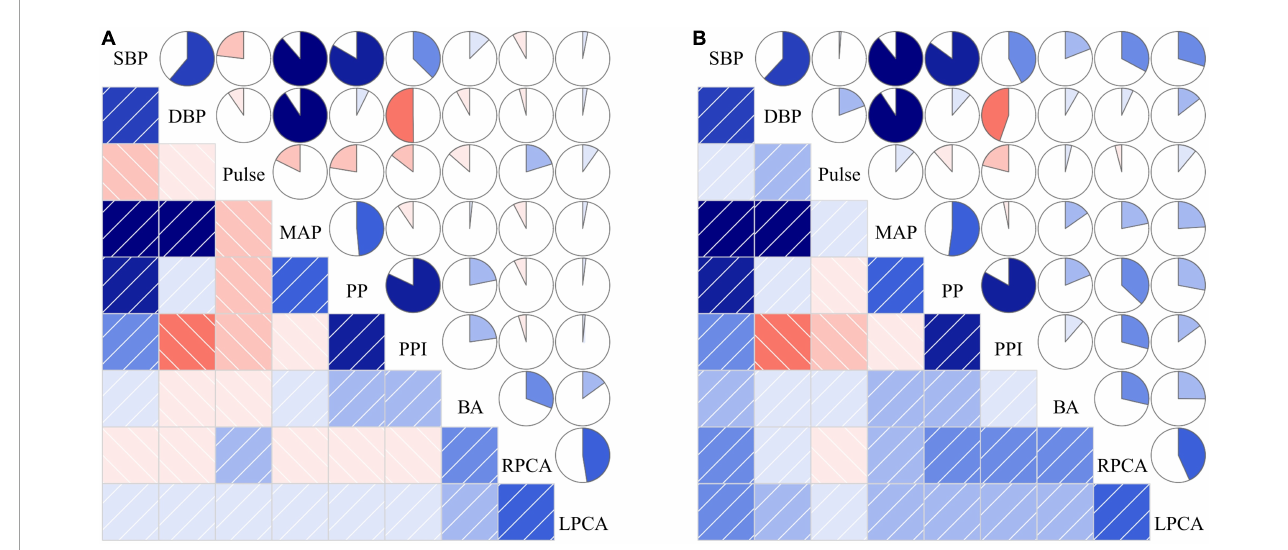
FIGURE5 The correlations between the means of various BP parameters and posterior circulatory artery stenosis score in CI (A) and non-CI (B) group. The correlations among risk factors can be categorized into two areas in the figure, the lower left and the upper right area. The lower left area: The blue squares with slashes starting from lower left corner to upper right corner indicate positive correlation of the two variables. The red squares with slashes starting from upper left corner to lower right corner indicate negative correlation of the two variables. The darker the color, the stronger the correlation of the two variables. The upper right area: The pie charts in blue which are filled in a clockwise direction are expressed as positive correlations of the two variables. The pie charts in red which are filled in a counterclockwise direction are expressed as negative correlations of the two variables. The larger the marked color area in the pie chart, stronger the correlation between the two variables. SBP, systolic blood pressure; DBP, diastolic blood pressure; MAP, mean arterial pressure; PP, pulse pressure; PPI, pulse pressure index; BA, the stenosis score of basilar artery; RPCA, the stenosis score of right posterior cerebral artery; LPCA, the stenosis score of left posterior cerebral